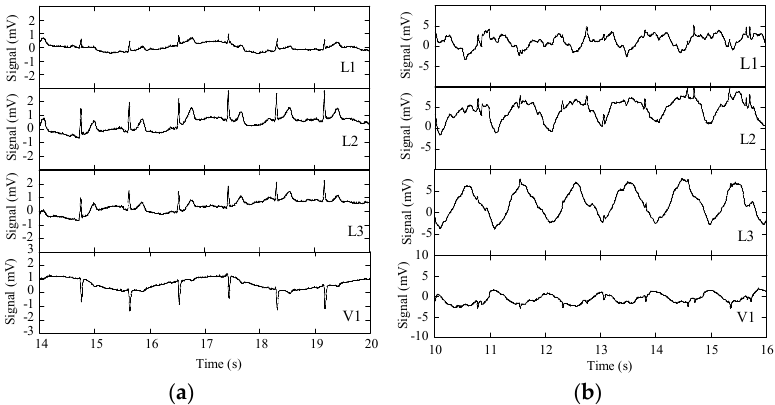
Figure 9. ECG signals L1, L2, L3, and V1 obtained with the subject wearing the cardiac surveillance T-shirt, embedding the DAT unit linked by Bluetooth to a smartphone; ( a ) subject standing; and ( b ) subject walking.